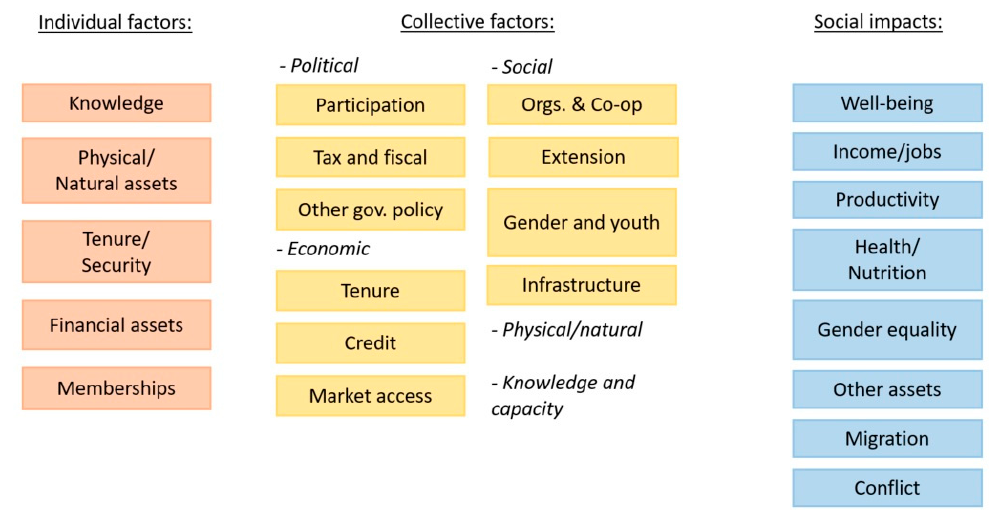
Figure 2. Overview of the factors influencing uptake of SLM and its impacts on well-being, as well as the recorded impacts of SLM, identified in the literature review.